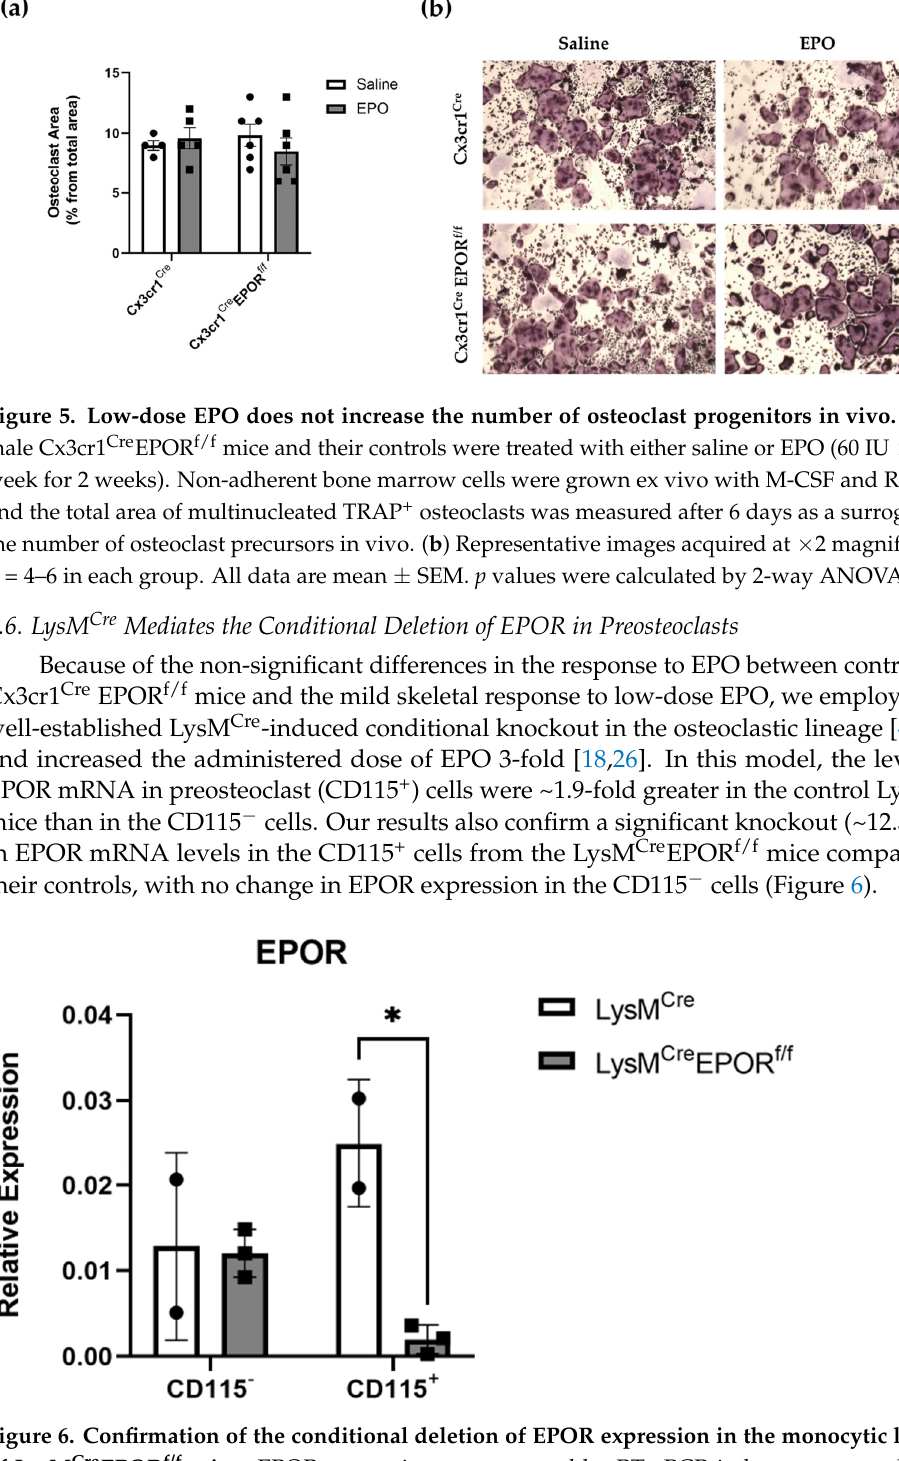
progenitors in the experimental animals or the controls (Figure 5). This suggests that un- like the high-dose treatment, low doses of EPO may stimulate bone resorption via specific effects on osteoclast differentiation [41] but not by increasing the number of preosteoclasts [18,26].